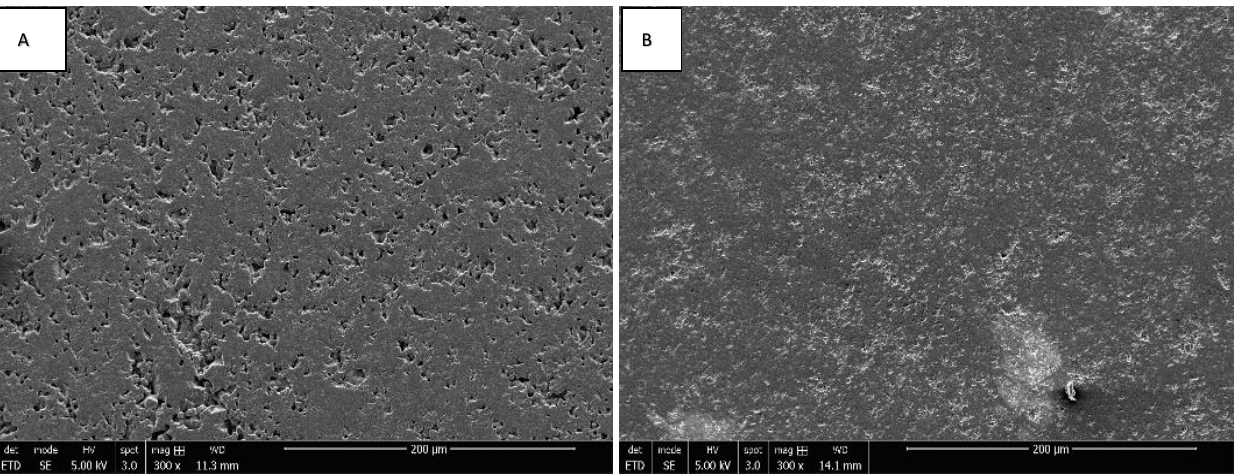
Figure 2. SEM images of rough (( A ) magnification 300 × ; ( B ) magnification 2500 × ) and smooth surfaces (( C ) magnification 300 × ; ( D ) magnification 2500 × ) of Y-TZP discs.